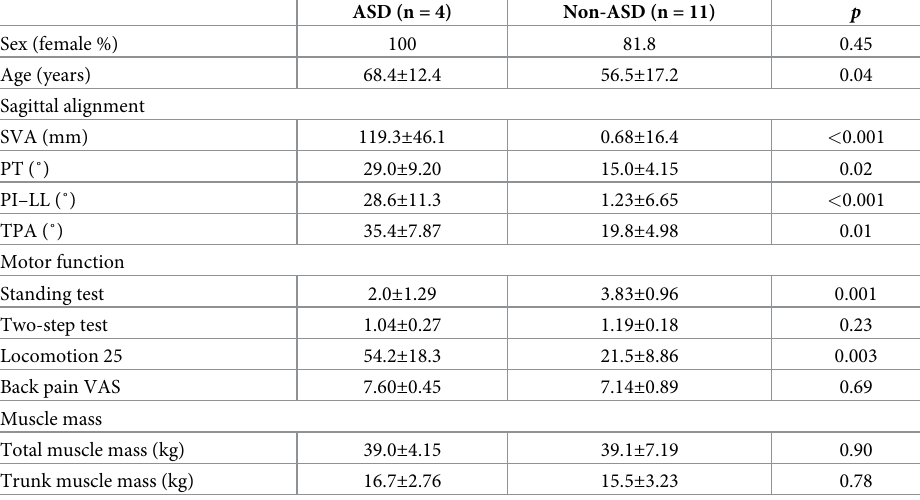
Table 1. General characteristics of all